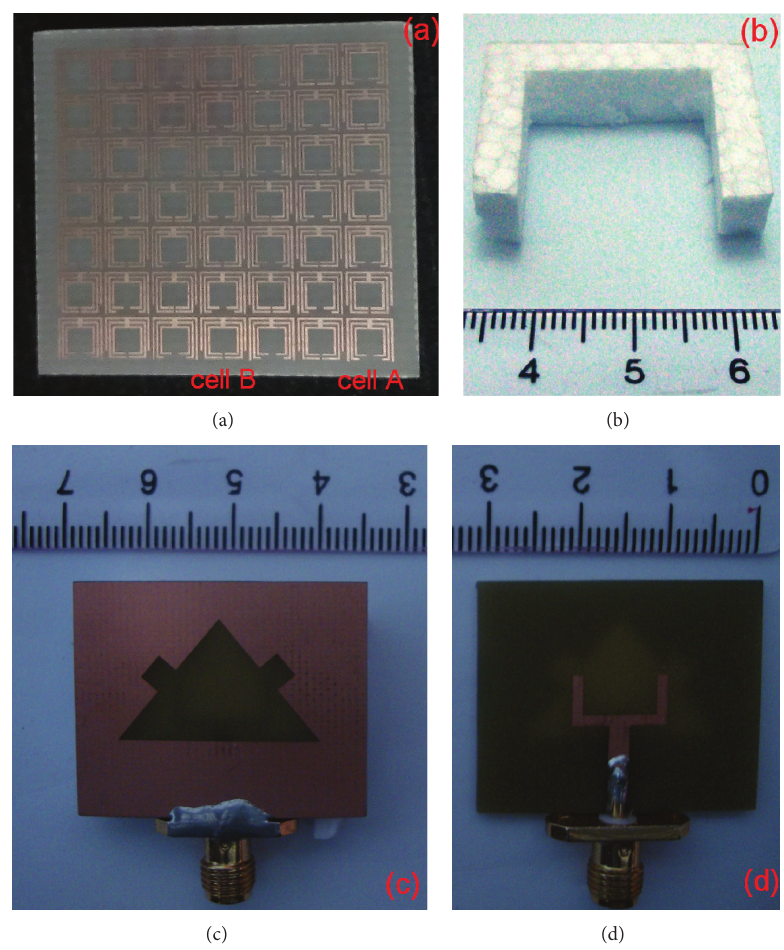
Figure 9: Photographs of the (a) FSS, (b) foam-based isolator, and (c) and (d) fabricated slot antenna.